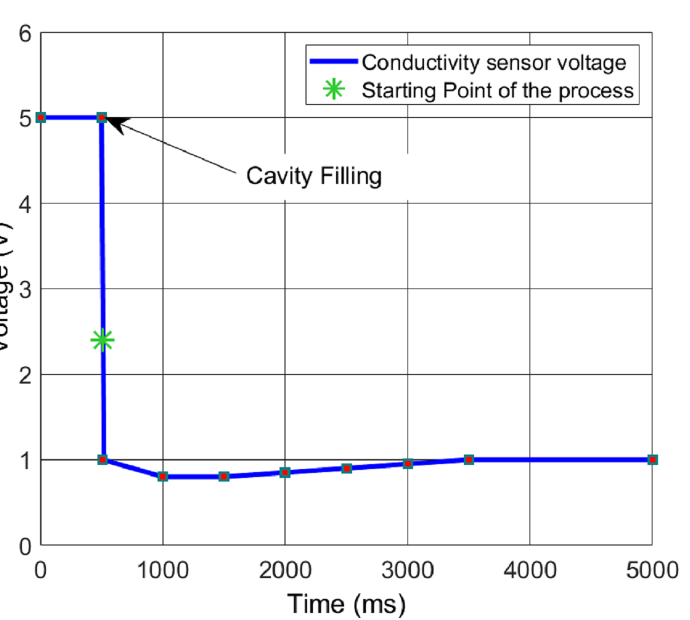
Figure 6. The output of the voltage divider as a function of the time is shown. The starting point is marked using an asterisk.